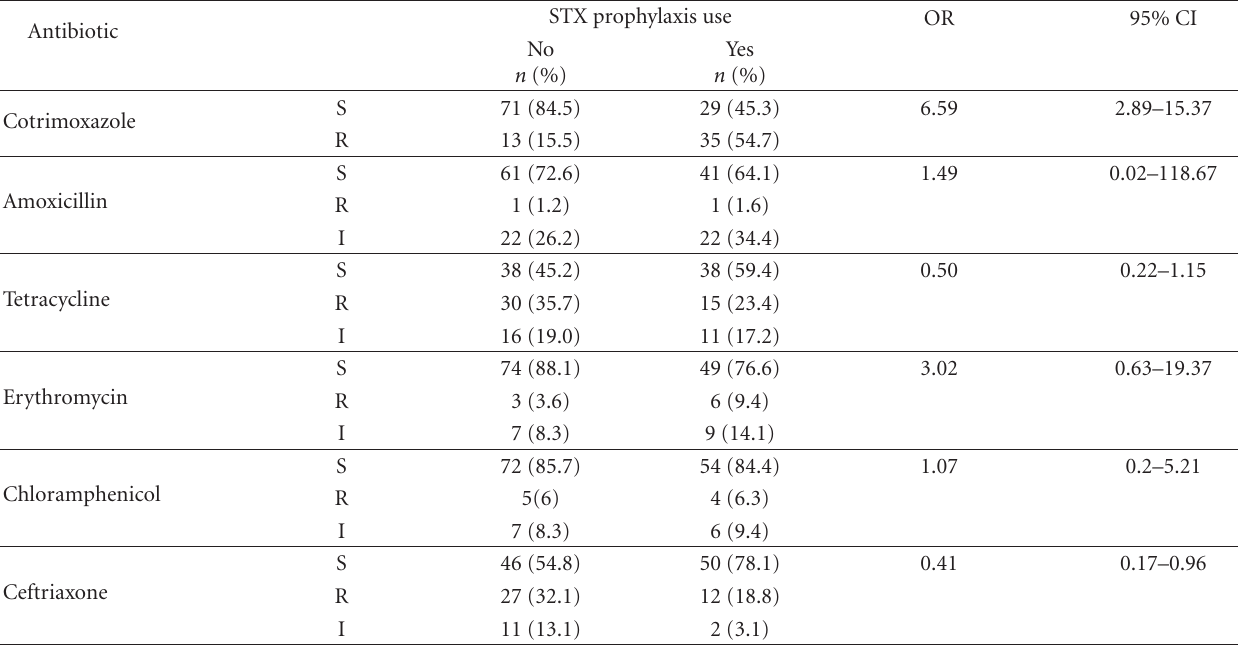
Table 2: Comparison of the di ff erent antibiotic susceptibilities of the nonprophylaxis and prophylaxis groups ∗ . Antibiotic